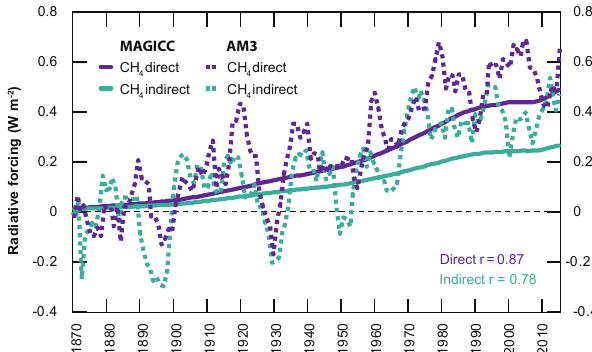
Figure 4. Same as Fig. 3, but showing direct (purple) and indirect (from methane’s influence on ozone and water vapour, green) forc- ings (Wm − 2